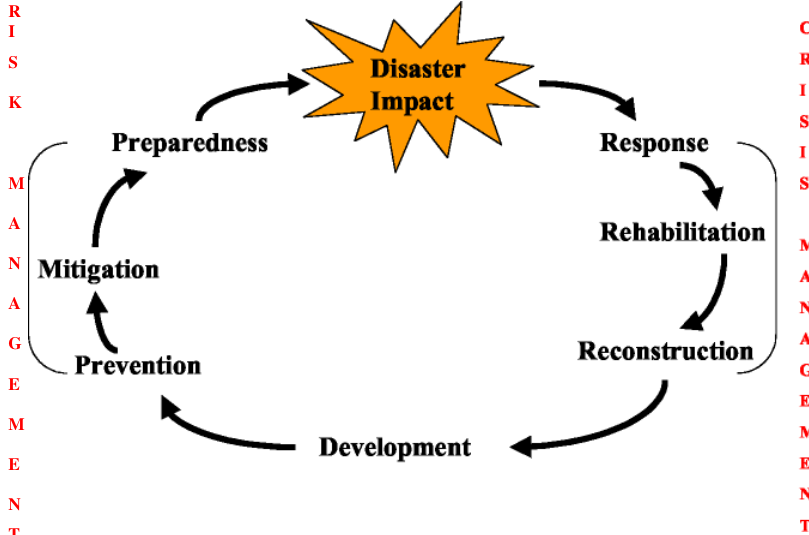
Figure 3. Disaster Management Cycle